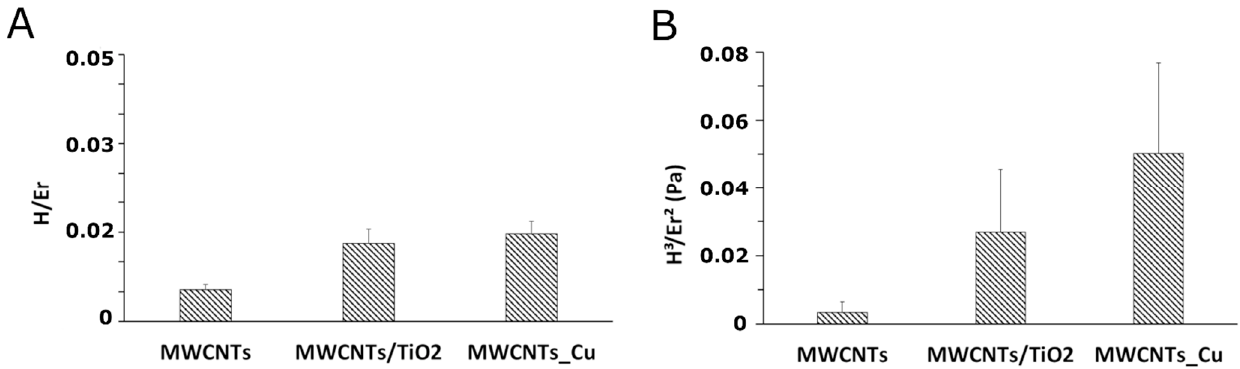
Figure 8. The diagrams for the H/Er ( A ) and the H 3 /Er 2 parameter ( B ) calculated for the MWCNTs bi-layer and the MWCNTs_Cu dispersion coating, examined under indentation load of 10 mN.